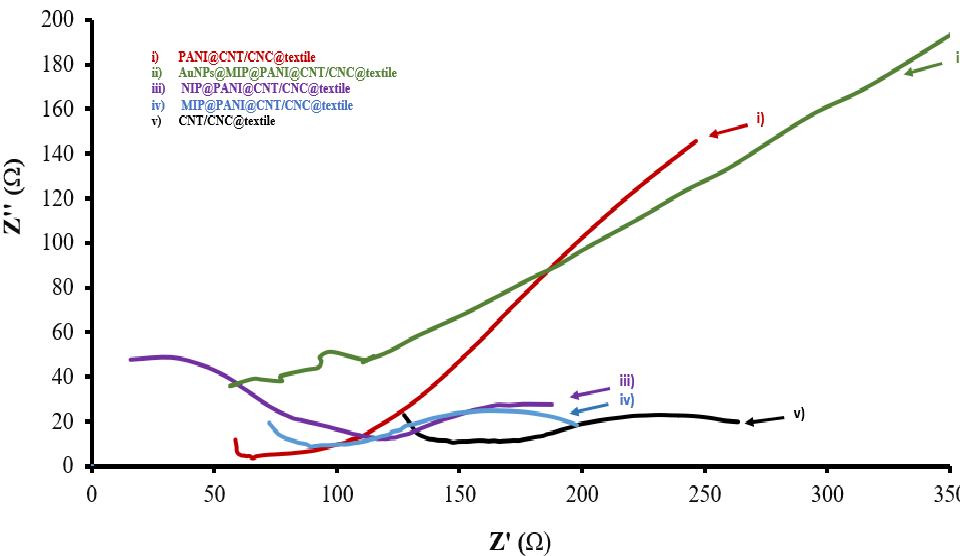
Figure 5. Overlapped Nyquist plots for (i) PANI@CNT/CNC@textile; (ii) AuNPs@MIP@PANI @CNT/CNC@textile; (iii) NIP@PANI@CNT/CNC@textile; 9 (iv) MIP@PANI@CNT/CNC@textile; and (v) CNT/CNC@textile